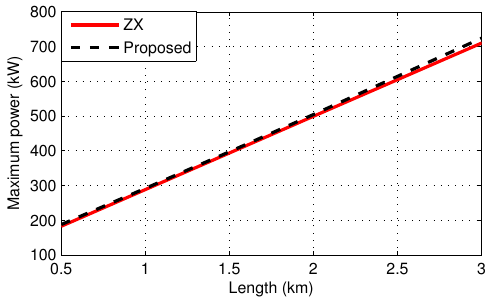
Figure 3. Maximum capacity power calculations for both models.